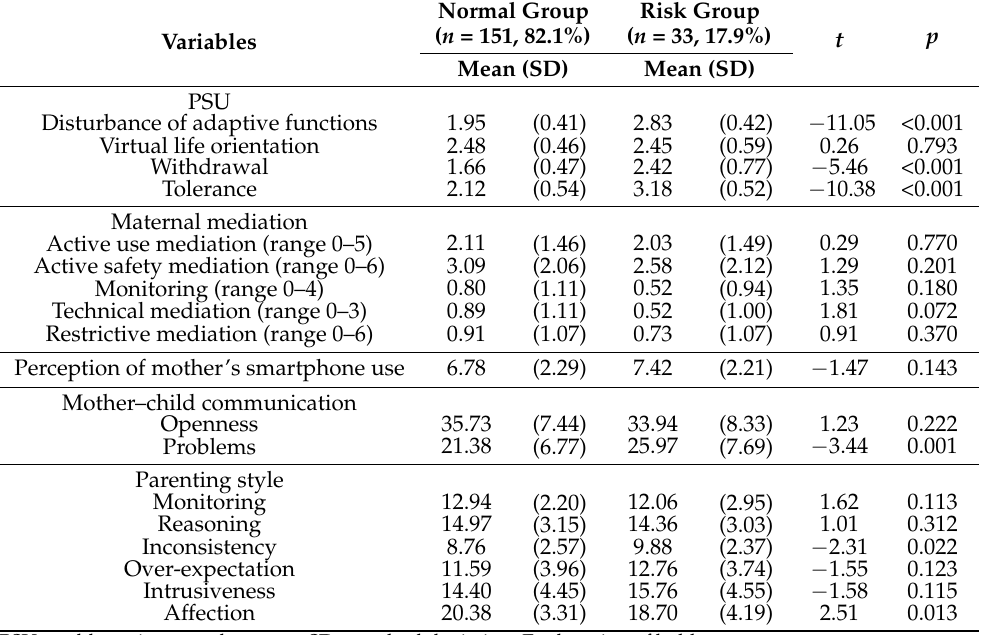
Table 2. The Difference in descriptive statistics of the study variables according to PSU ( n =